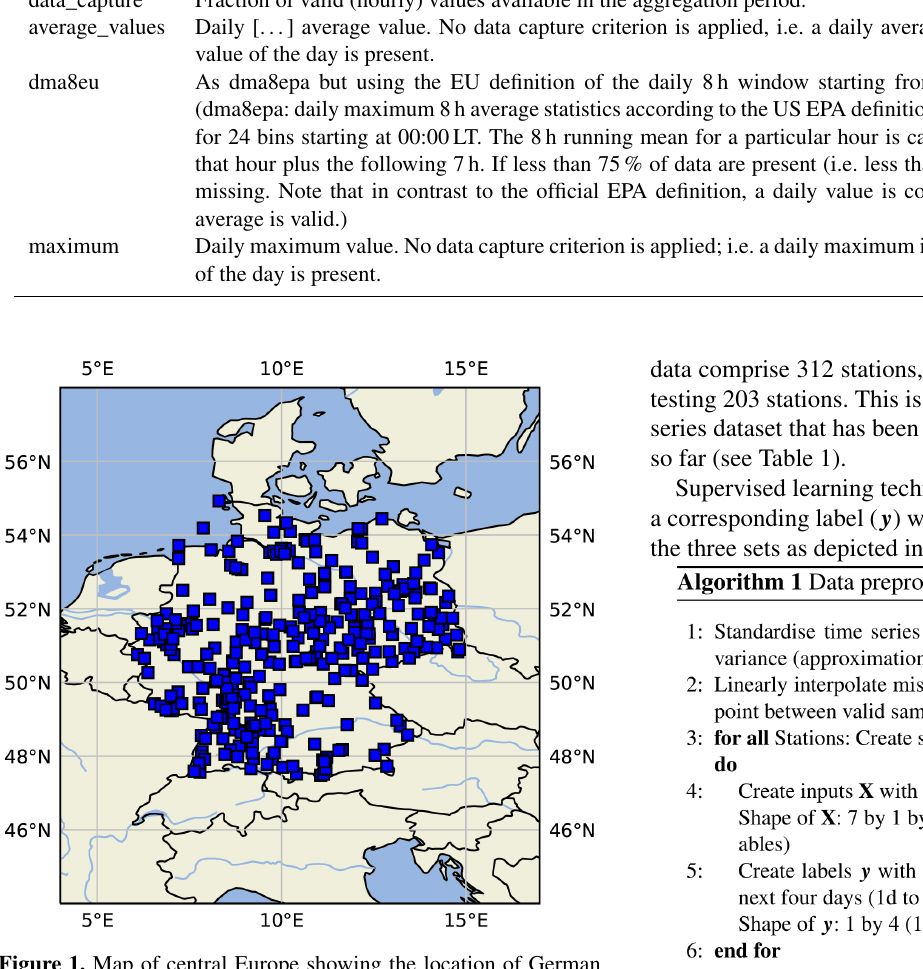
Figure 1. Map of central Europe showing the location of German measurement sites used in this study. This figure was created with Cartopy (Met Office, 2010–2015). Map data © OpenStreetMap con-